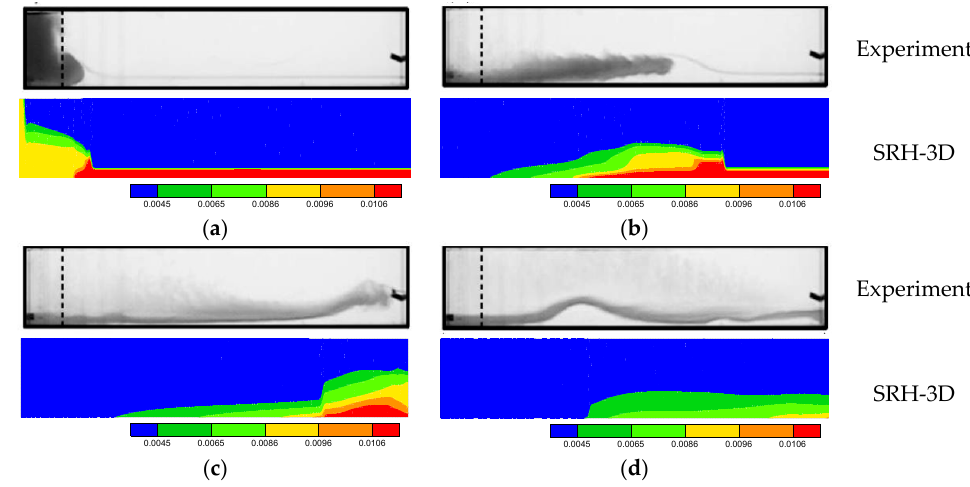
Figure 12. Temporal evolution of the AFTC intrusive gravity current—sediment concentration contours. Experiment is from [52] and visualized by adding dye. ( a ) Time = 2 s; ( b ) Time = 14 s; ( c ) Time = 26 s; ( d ) Time = 38 s.